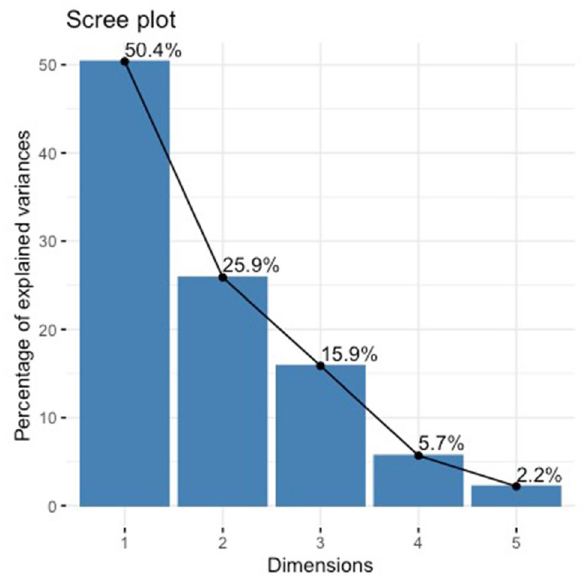
Figure 3. Percentage of variance explained by dimensions extracted by correspondence analysis.